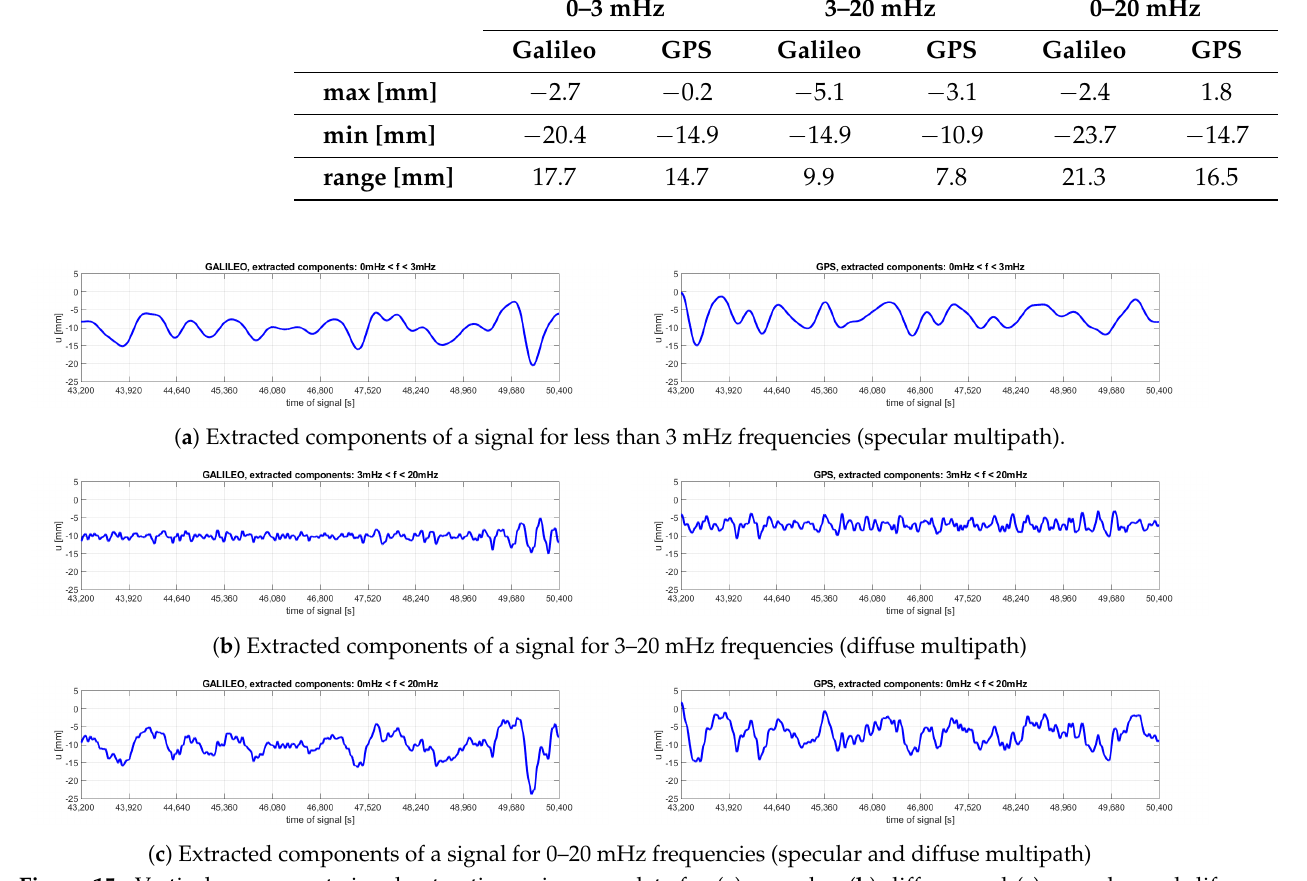
Figure 15. Vertical component signal extraction using wavelets for ( a ) specular, ( b ) diffuse, and ( c ) specular and dif- fuse